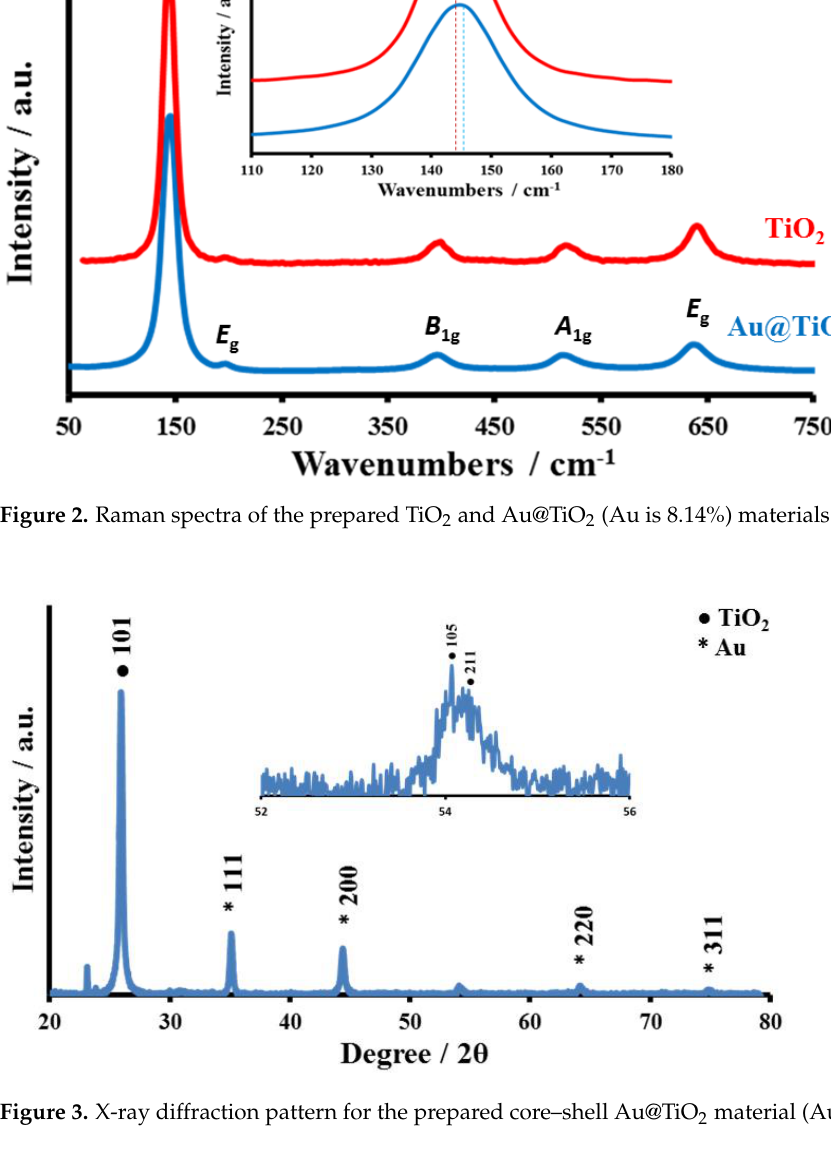
Figure 3. X-ray diffraction pattern for the prepared core – shell Au@TiO 2 material (Au = 8.14%).